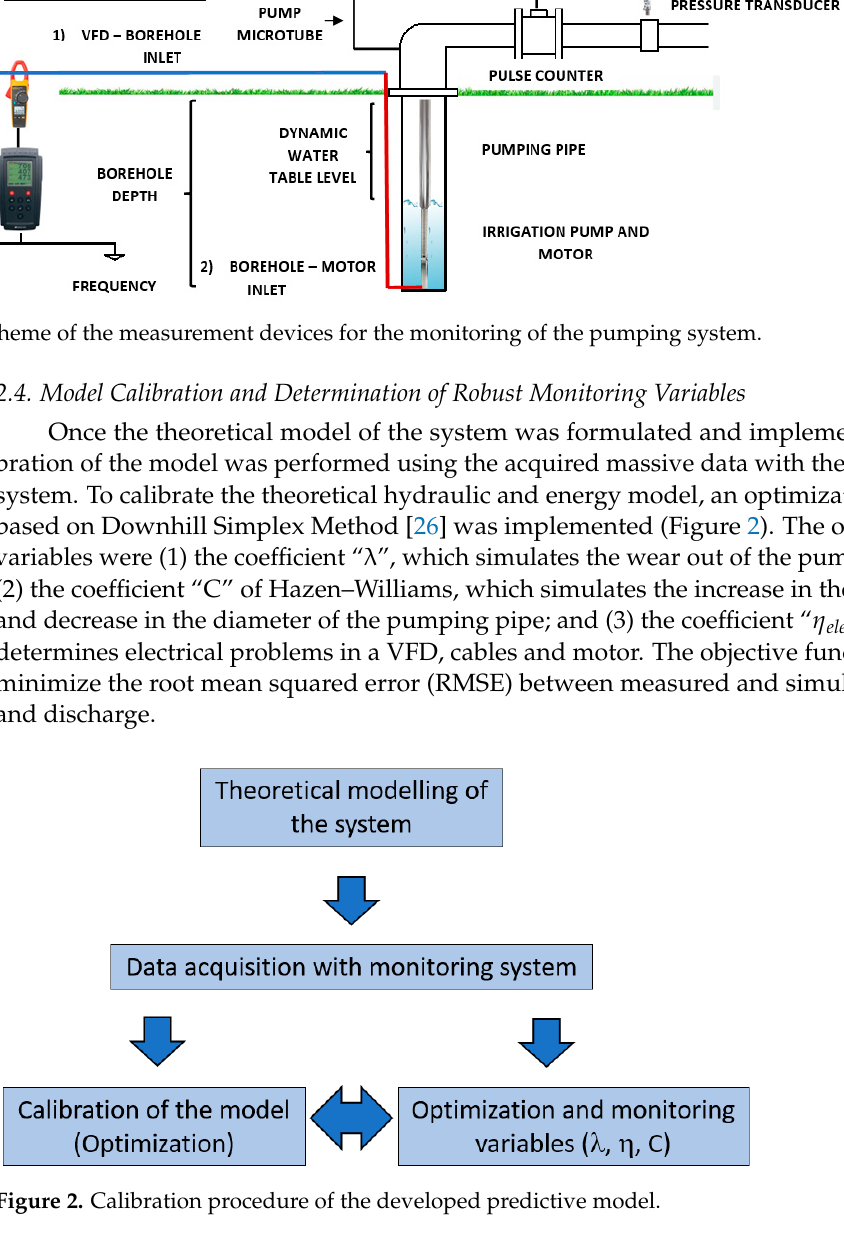
Figure 2. Calibration procedure of the developed predictive